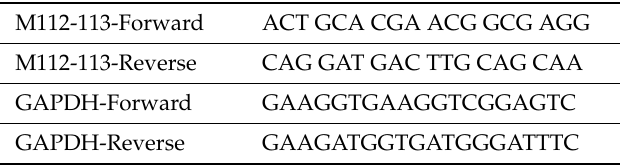
Table 3. Primers for real-time RT-PCR of